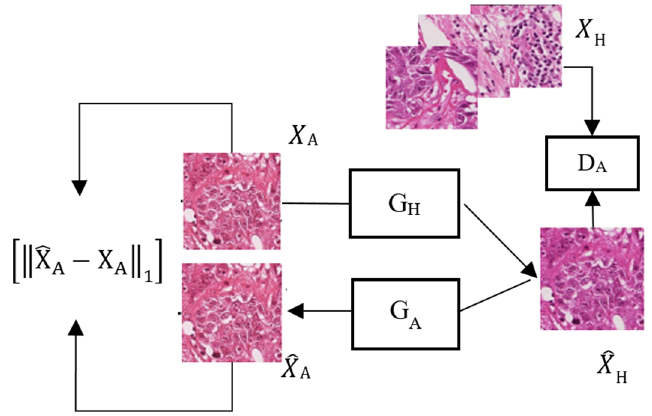
Figure 2. System architecture of StainGAN.